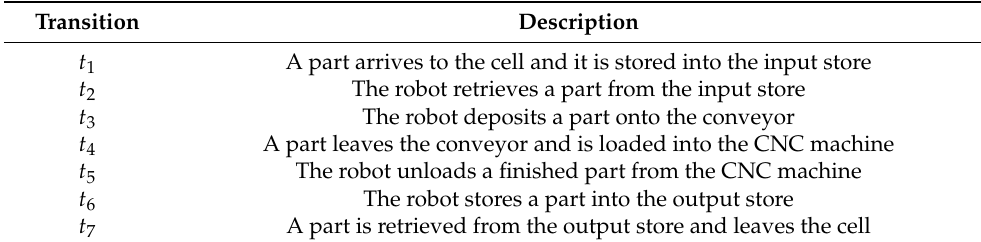
Table 2. Transitions and their description in the TCPN model of Figure